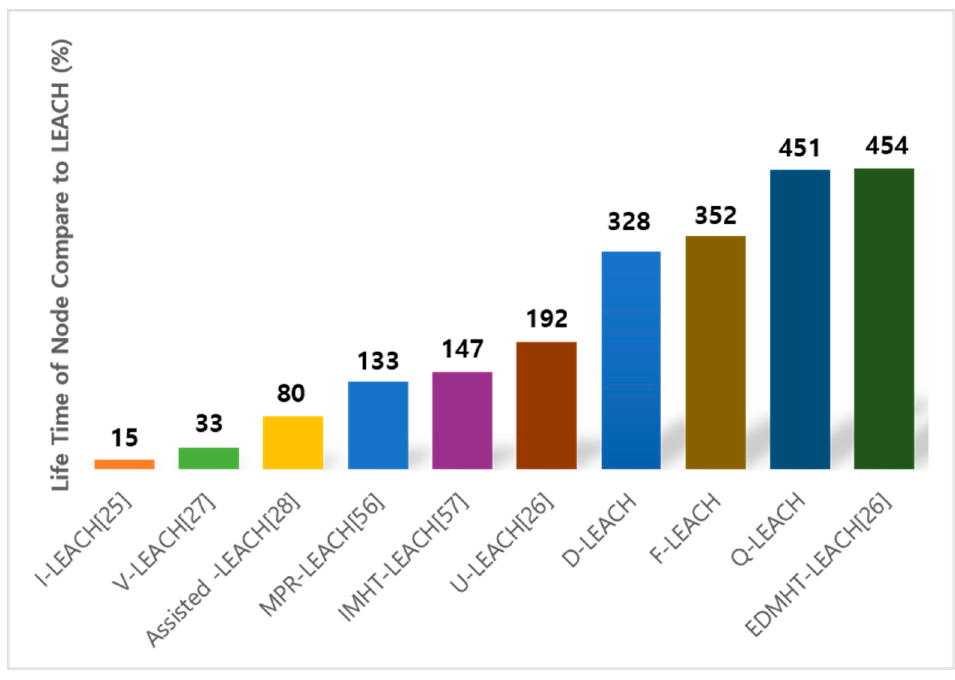
Figure 10. The comparison with related work.